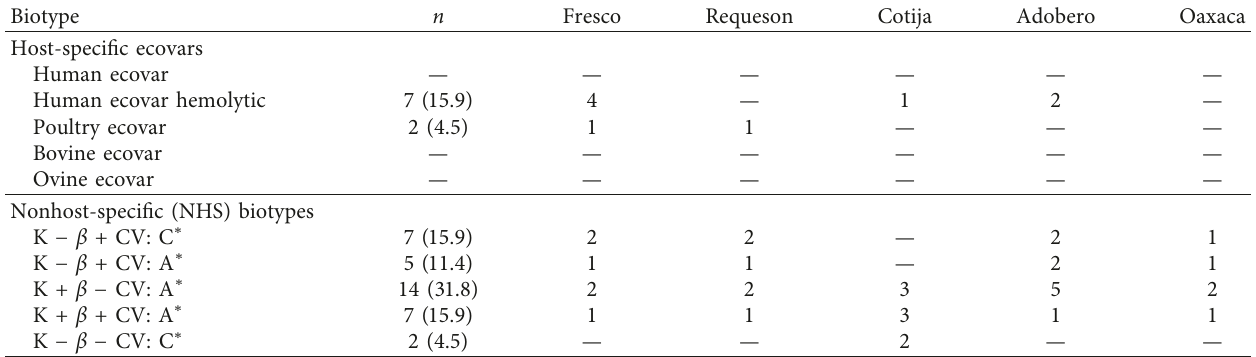
Table 1: Staphylococcus aureus biotype distribution in Mexican artisanal cheese. Biotype n Human ecovar hemolytic Bovine